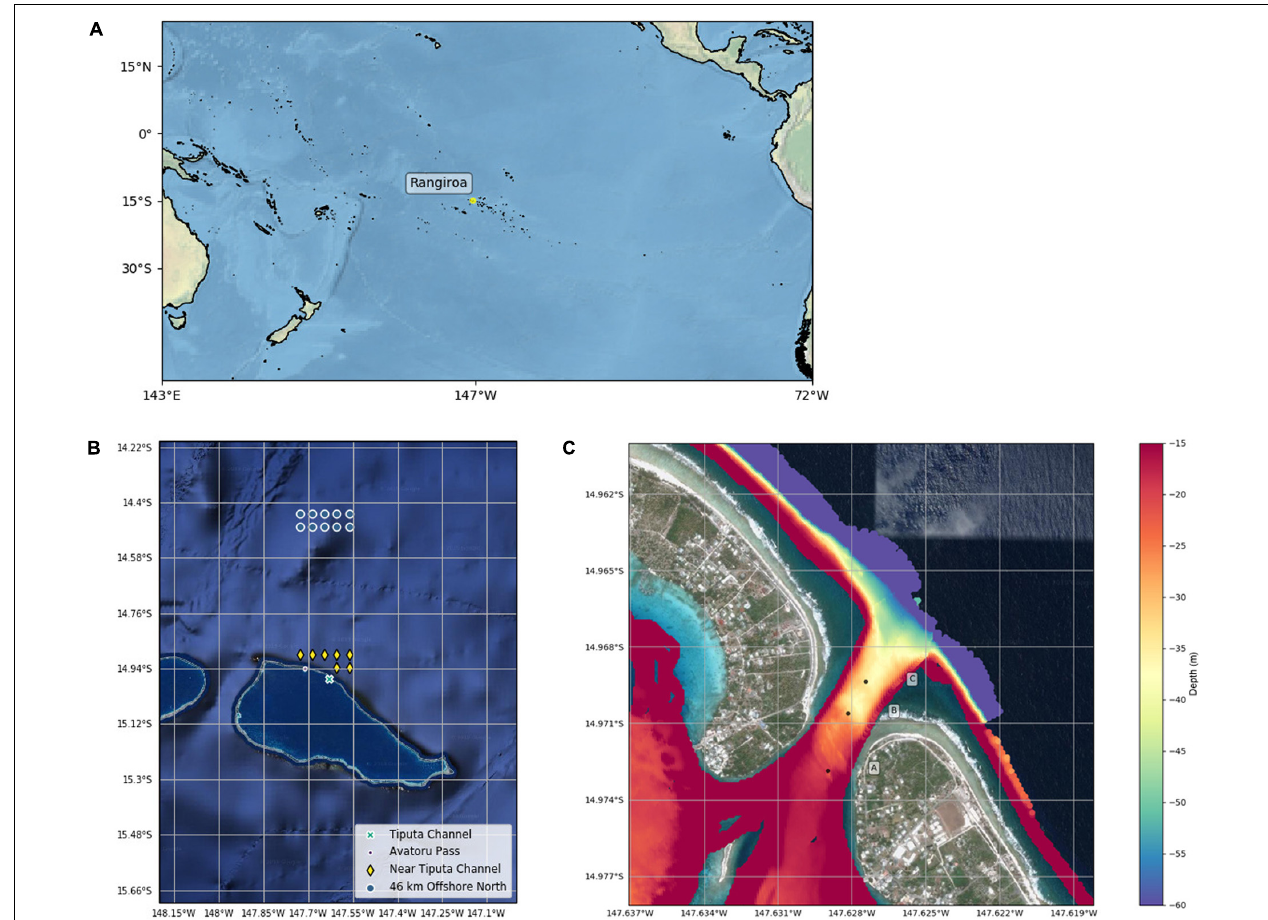
FIGURE 1 | (A) Southern Pacific Ocean map with Rangiroa. (B) Satellite image of Rangiroa with Tiputa Channel, Avatoru Pass, and MODIS data near and approximately 50 km north of Tiputa Channel. (C) Bathymetric data from Tiputa Channel collected by the Secretariat of the Pacific Community Applied Geoscience Division (SOPAC) overlaid on a Google satellite image. Deployment locations of three moorings are marked A, B, and C. The color bar shows depth in meters.